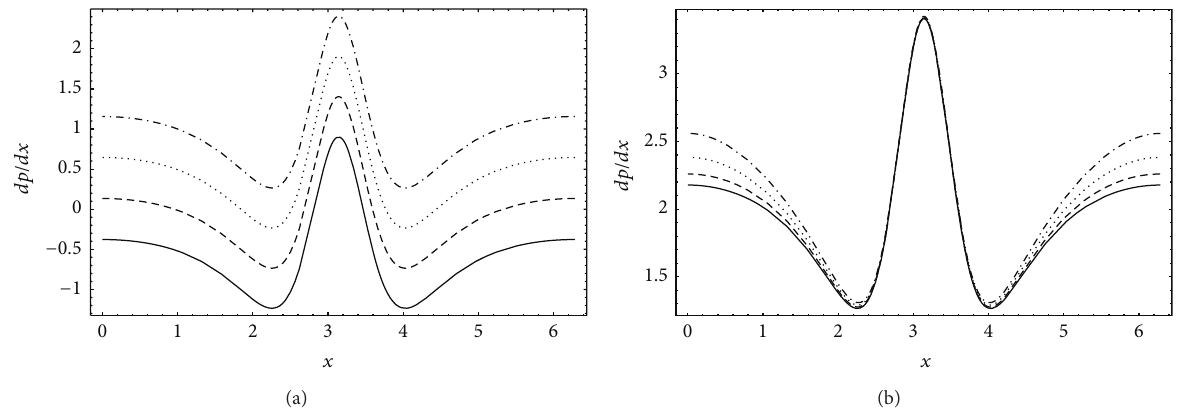
Figure 4: Axial pressure gradient 𝑑𝑝/𝑑𝑥 for 𝑎 = 0.7 , 𝑏 = 1.2 , 𝑑 = 2 , 𝜙 = 0 , 𝑏 𝑠 = 0.01 , 𝑛 = 2 , and 𝜃 = 1.8 : (a) 𝑁 = 0.1 , = 2 , and = 3 (b) Gr = 5 , ... Gr . . . Gr